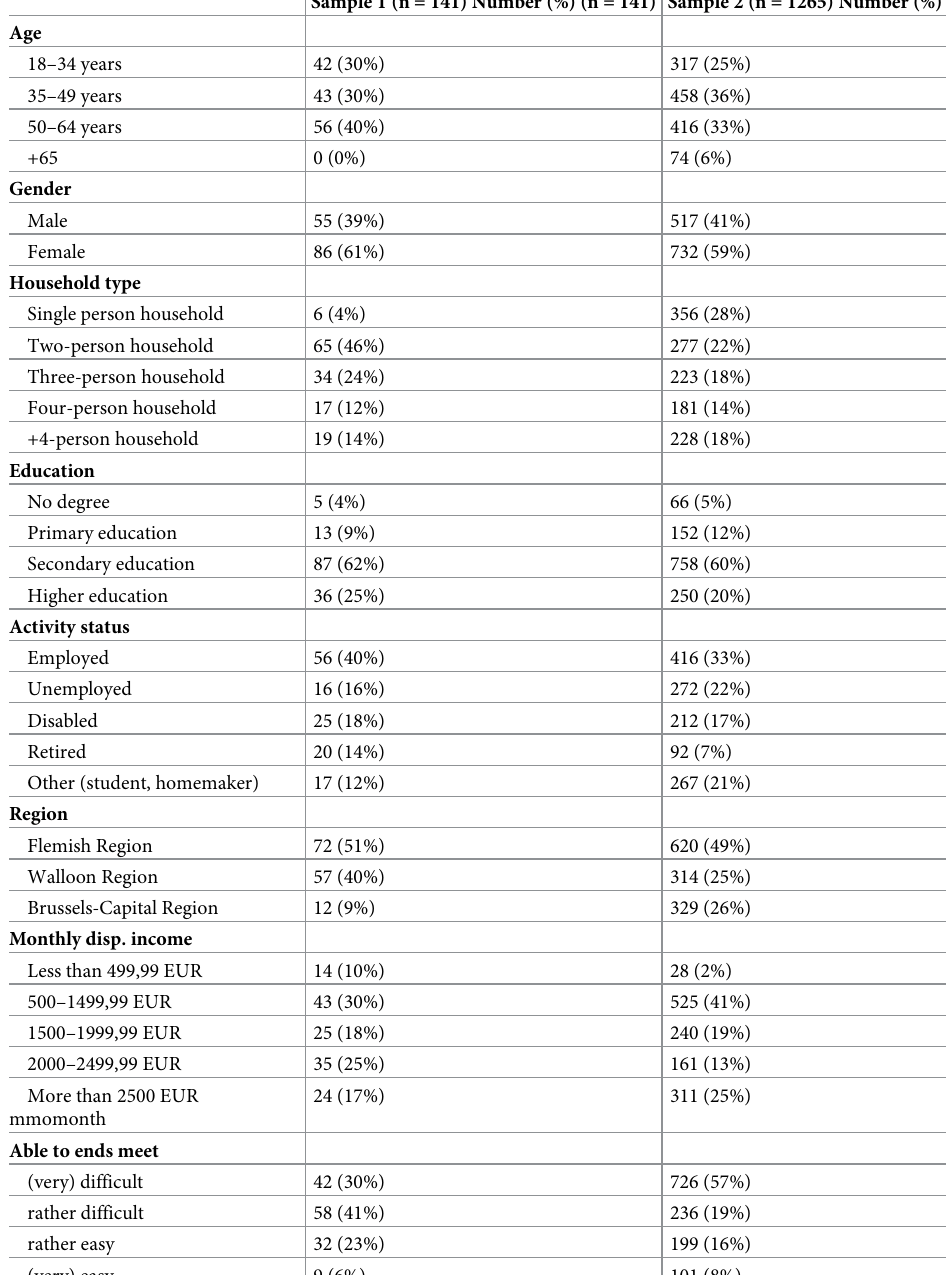
Table 1. Characteristics of the study